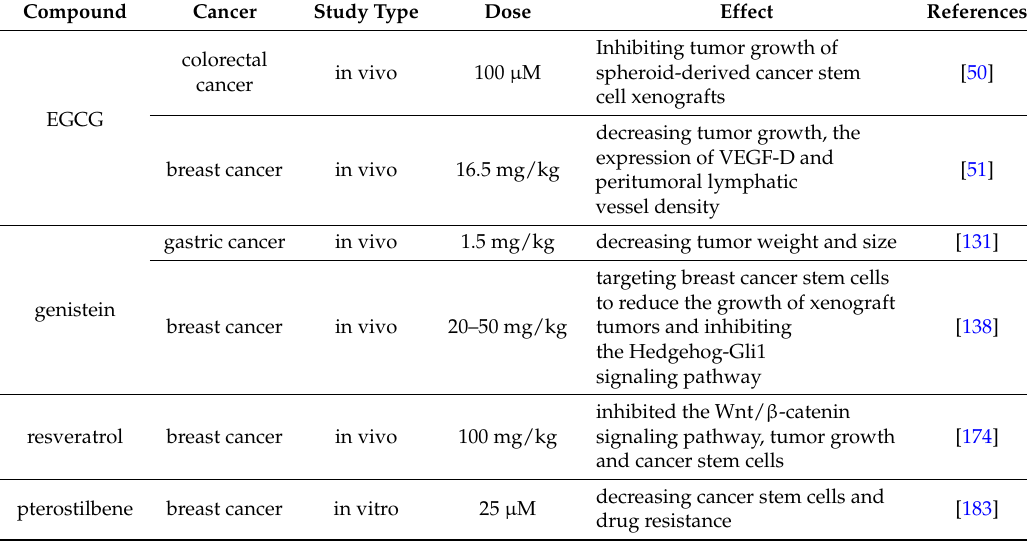
Table 4. The anti-cancer stem cell effects of